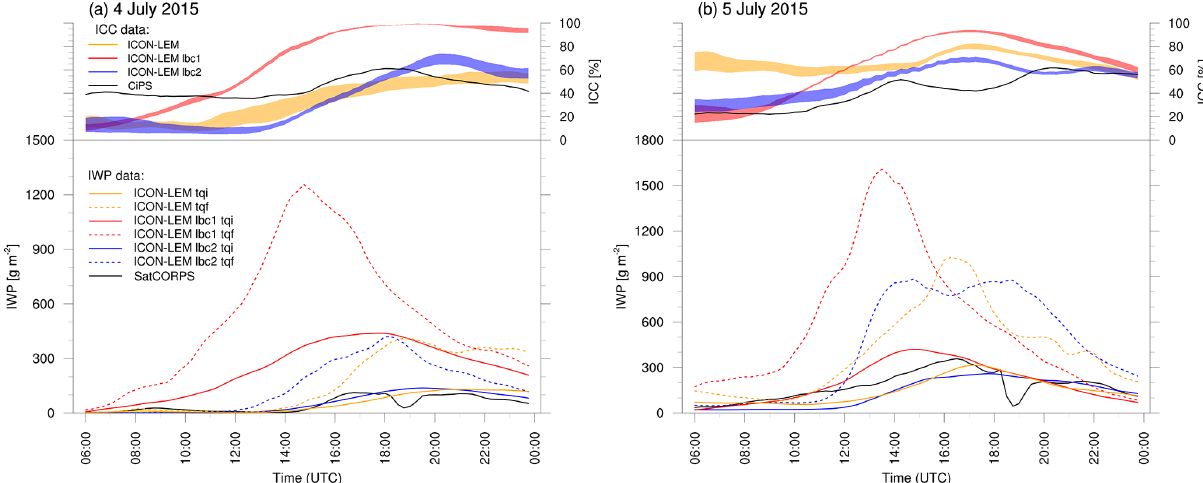
Figure 8. Similar to Fig. 5, but displaying the change in the temporal evolution of ICC and IWP when varying the initial conditions for 4 July 2015 (a) and 5 July 2015 (b) . Only SatCORPS observations are shown as a reference. The yellow, red, and blue lines correspond to simulations forced with lateral and initial conditions from COSMO, ICON-NWP, and IFS,